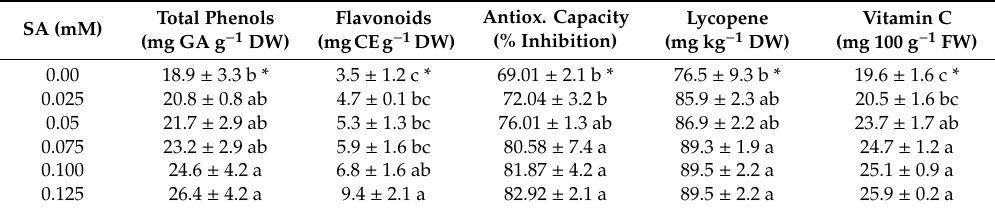
Table 3. Nutraceutical quality of tomato fruits as a ff ected by SA foliar